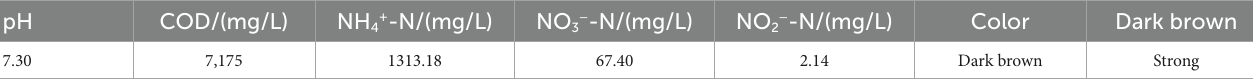
Values are given as an